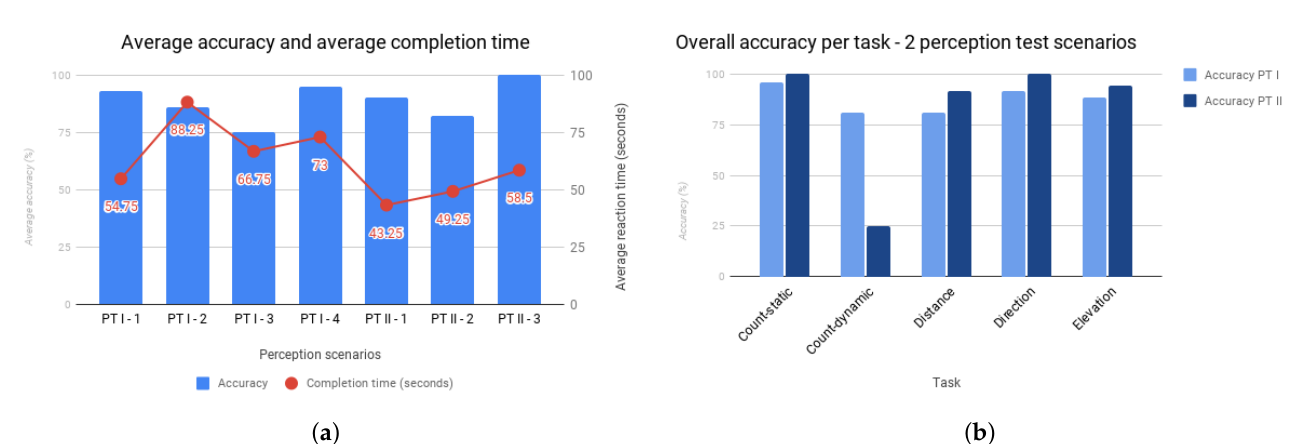
Figure 7. ( a ) Average accuracy and completion time over all users in perception tests ( b ) Average per task accuracy over all users in both perception